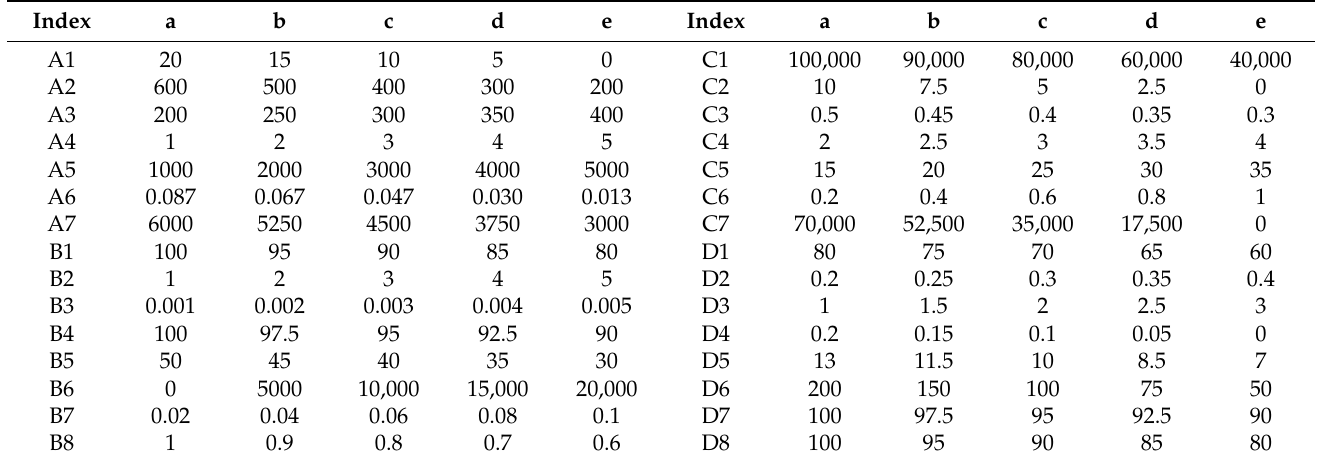
where µ k is the membership of indicator; x k is the indicator value; a k , b k , c k , d k , e k are the characteristic values of the indicator; a is the worst value, expressed by the worst level of the index Yellow River Basin; b is the difference value, which is determined by interpolation; c is the passing value, expressed according to the average level of the Yellow River Basin and Henan Province; d is the better value, which is determined by interpolation; e is the best value, expressed by the optimal level of the index Yellow River Basin. The selection of the characteristic values of each indicator is shown in Table 2. Table 2. The characteristic value of the